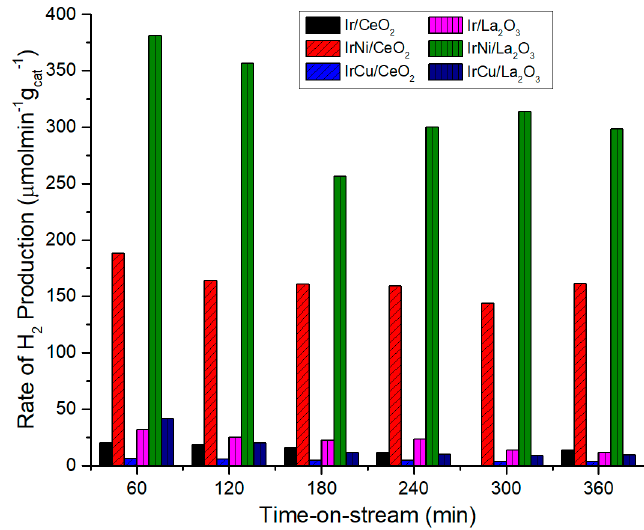
Figure 11. H 2 Yield Rate at 270 °C and 58 bar.